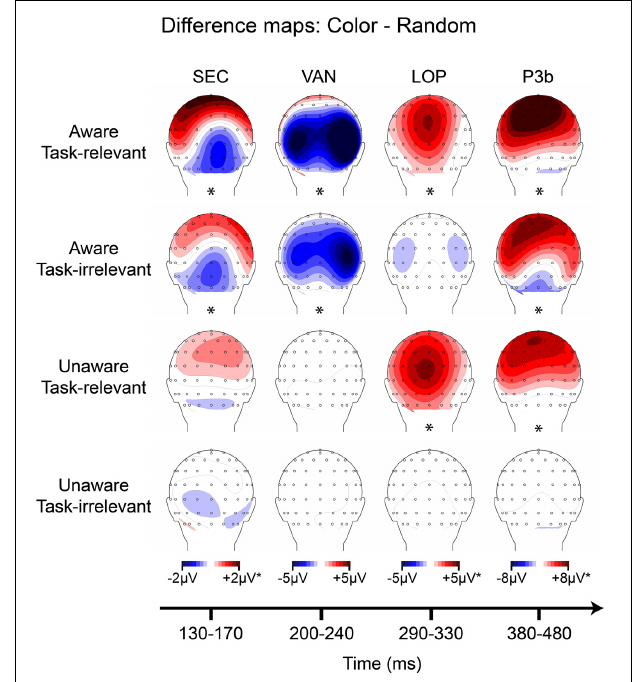
FIGURE 8 | Grand-averaged difference wave topographies (square minus random) plotted over the posterior scalp for the four components of interest (columns) across the four main experimental conditions (rows). Note that the amplitude scale for the CIN component was adjusted to ± 1 µ V for the unaware conditions, and for the VAN component ± 2 µ V for all conditions except the aware, task-relevant condition. Asterisks indicate significant amplitude differences ( p < 0 . 05) between shape and random ERP as assessed via cluster mass permutation tests for each condition separately.